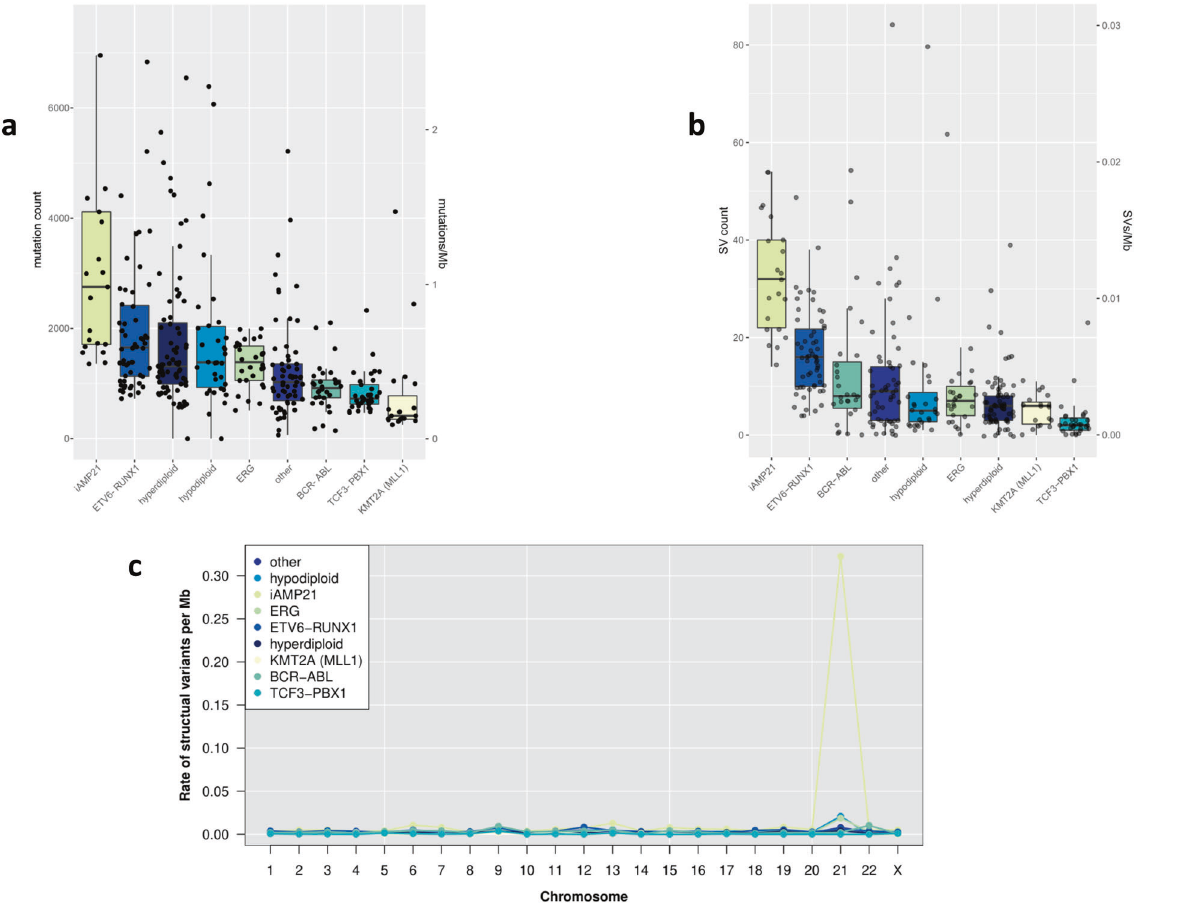
Fig. 1 Mutation burden by subtype. Short somatic variants (SNVs and indels) were called in 361 matched normal/tumour whole genome sequencing samples. a Burden of SNVs and indels. Box and whiskers plot of mutation count per tumour. b Burden of structural variants (SVs). Box and whiskers plot of SV count, dots represent individual tumours. c Plot of the SV rate per chromosome retaining only intrachromsomal variants outside immunoglobulin loci. Y- axis; mean SVs rate per Mb. X- axis;